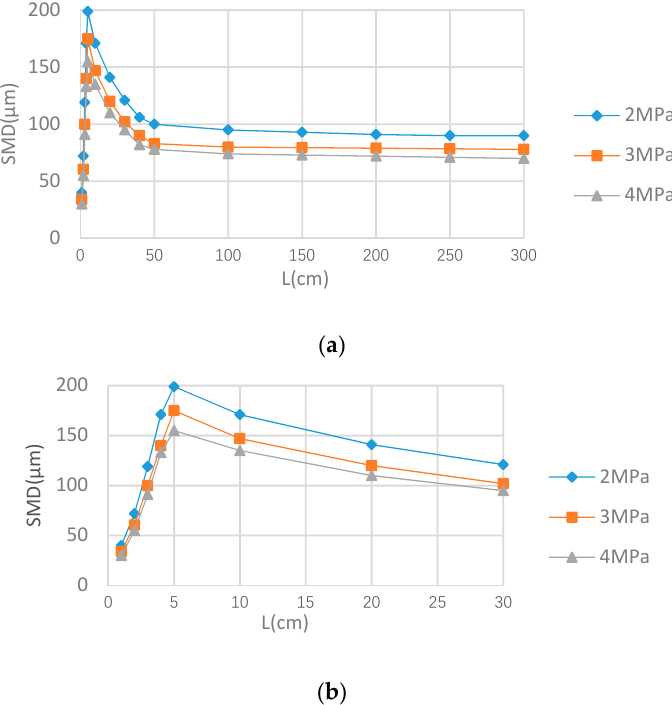
Figure 8. The axial distribution of droplet diameter. ( a ) The axial distribution of droplet diameter over 300 cm. ( b ) The axial distribution within 30 cm.